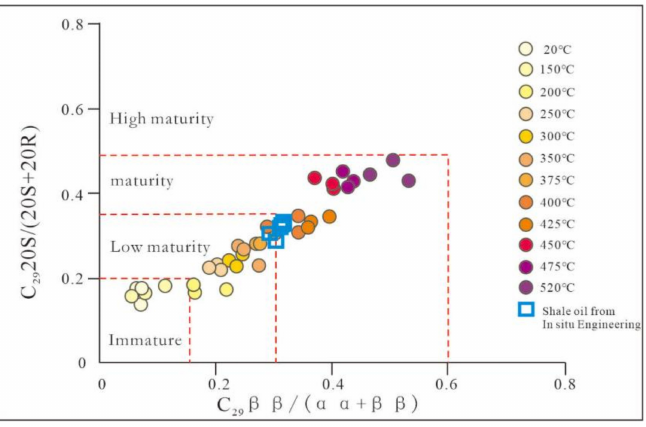
Figure 12. Analysis of C 29 sterane 20S/(20S + 20R) and C 29 sterane ββ /( αα + ββ ) on maturity.